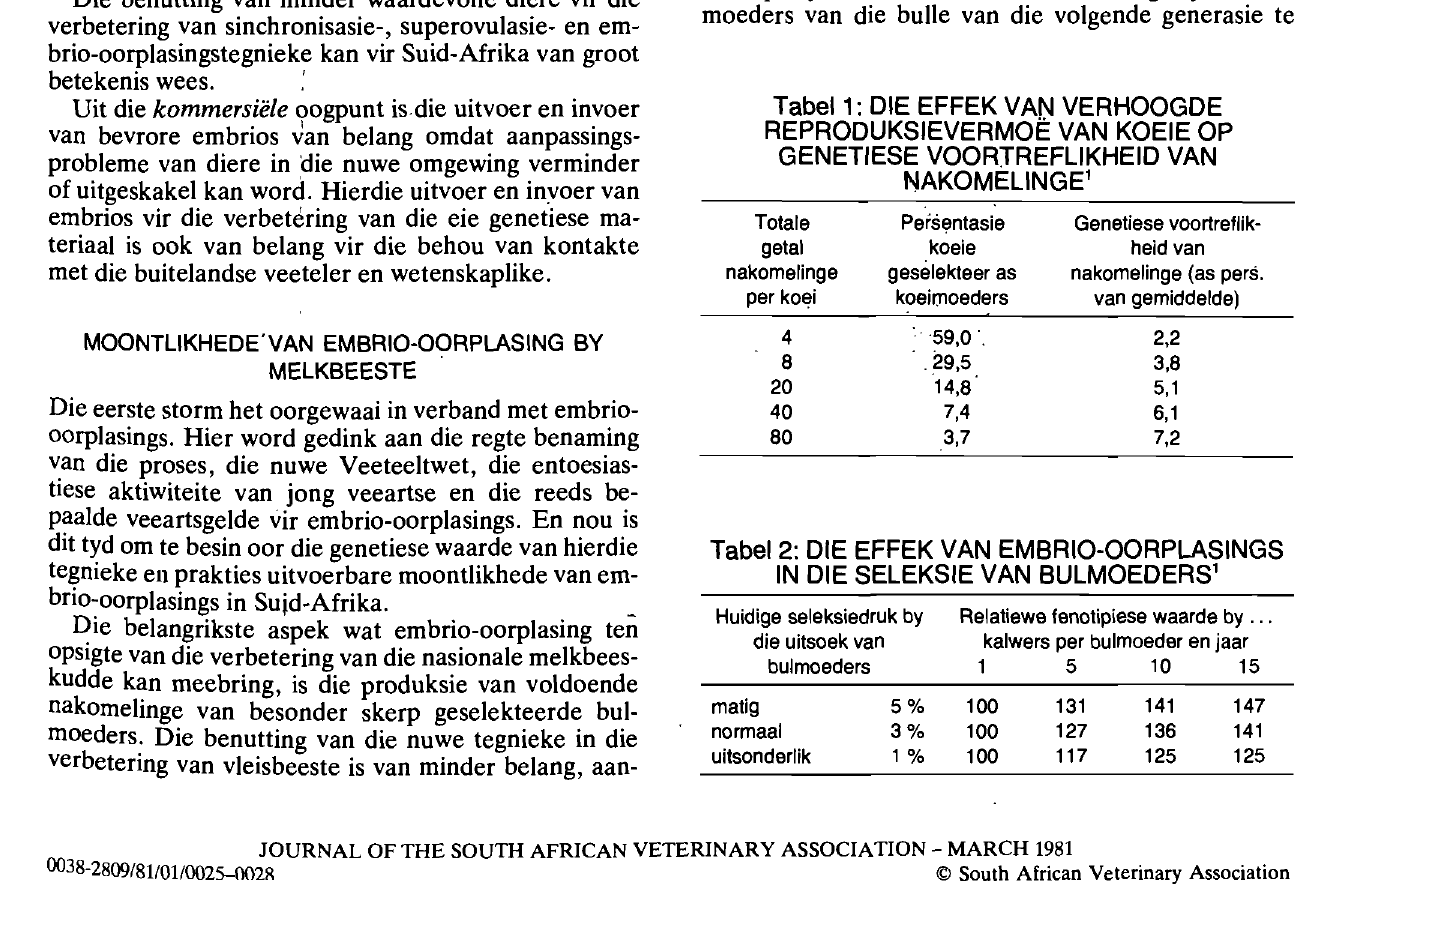
Tabel 1: DIE EFFEK VAN VERHOOGDE REPRODUKSIEVERMOE VAN KOEIE OP GENETIESE VOORTREFLIKHEID VAN